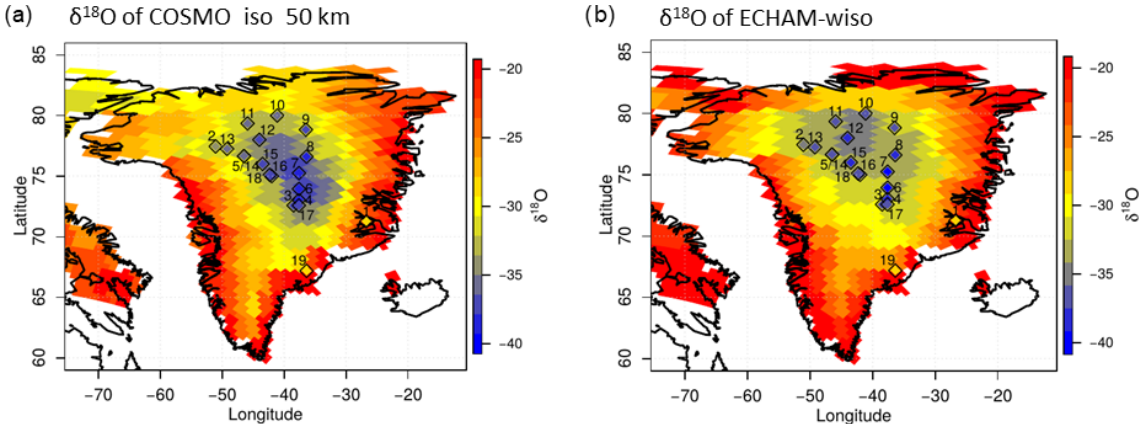
Figure 3. Yearly mean δ 18 O values of COSMO_iso_50km (a) and ECHAM5-wiso ( b , interpolated to the COSMO_iso_50km grid) for the period 2008–2014 and the corresponding observations for the 19 snow pit samples (Table